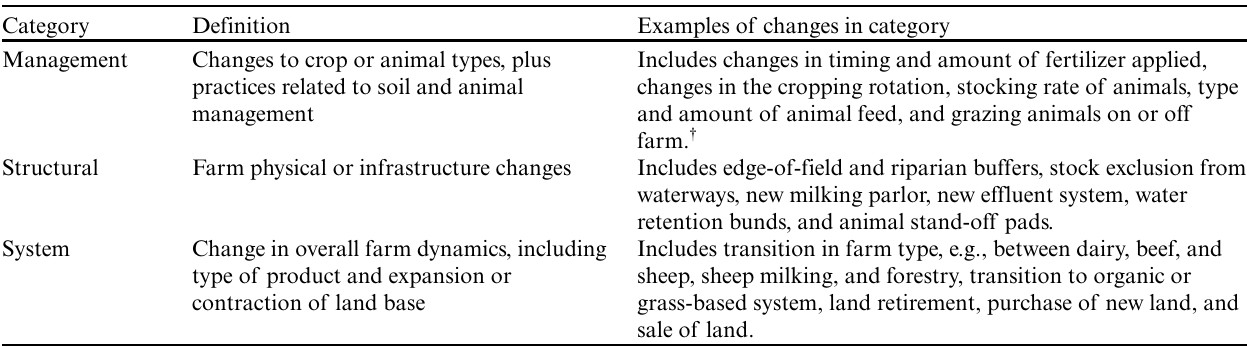
Table 3 . Categories of nutrient management behavior changes on farms.